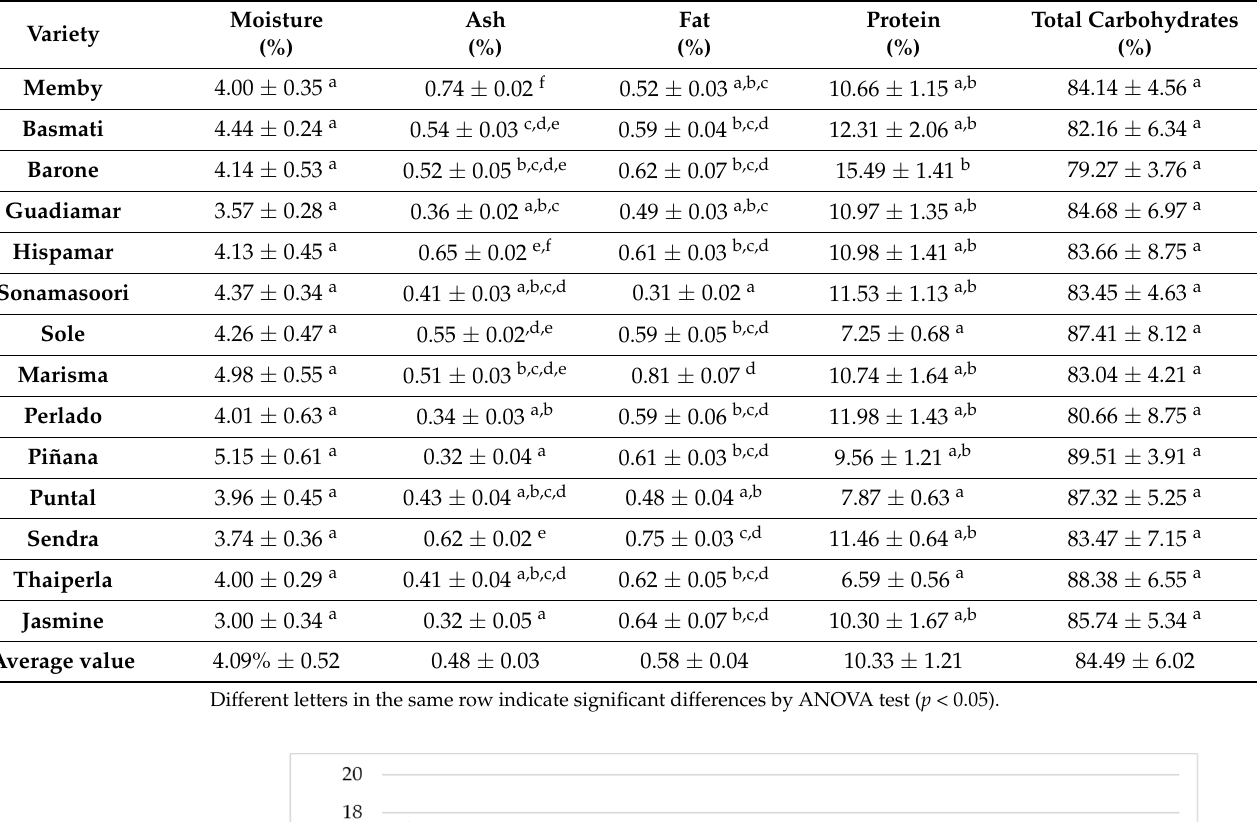
Table 7. Chemical composition of 14 major varieties of cooked rice consumed in Spain.